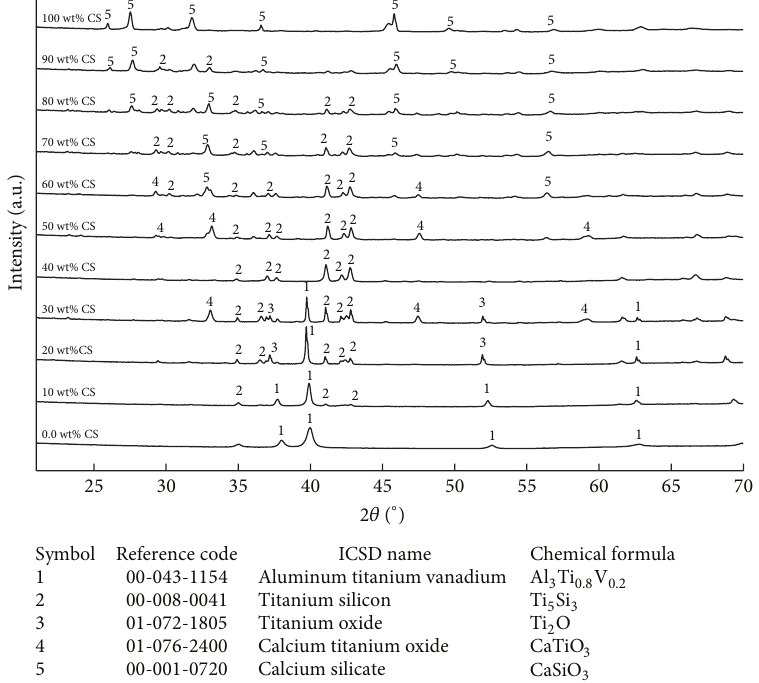
Figure 7: XRD patterns of Ti-6Al-4V/CaSiO 3 sintered cermets with different CS contents. New phases are revealed from 10 to 90wt% CS contents in TAV/CS